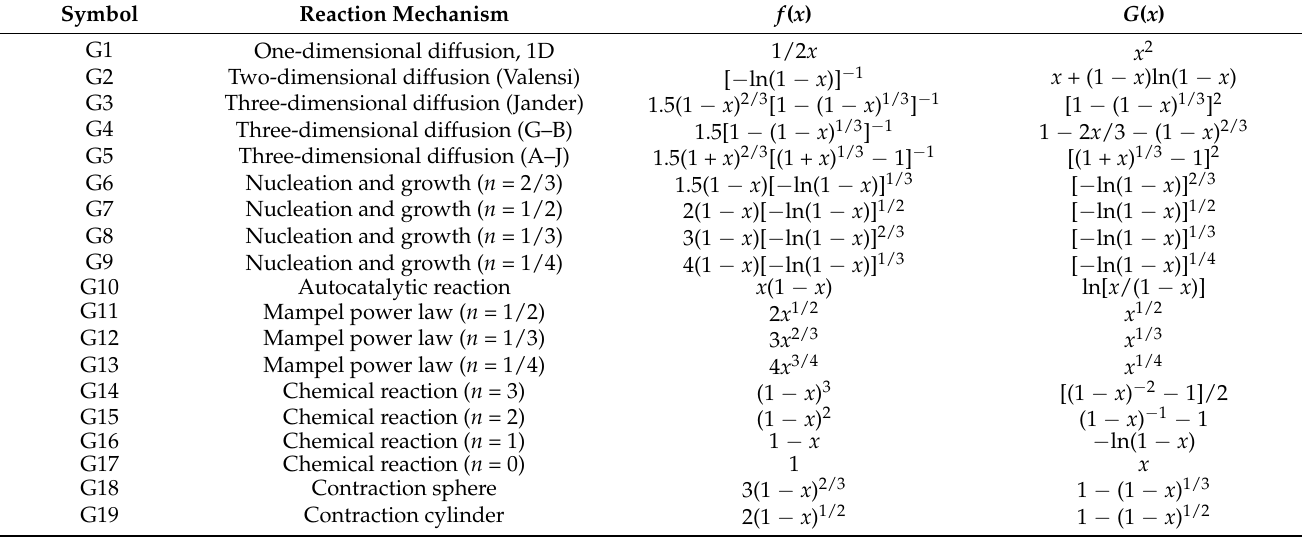
Table 3. Typical mechanisms for the solid–gas reaction,(LN: 5235900730034) [38].